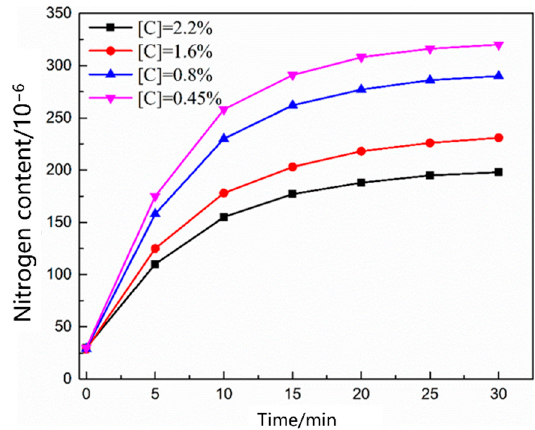
Figure 5. Change in the nitrogen content in the liquid steel with different carbon contents.